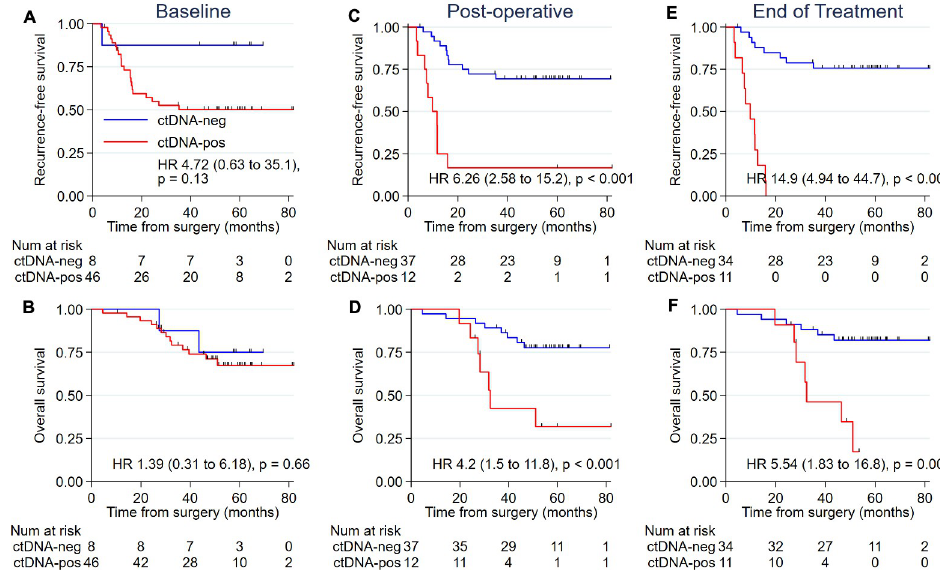
Fig 5. RFS and OS according to ctDNA status at different time points. (A) RFS for baseline ctDNA (T 0 ). (B) OS for baseline ctDNA (T 0 ). (C) RFS for postoperative ctDNA (T P ). (D) OS for postoperative ctDNA (T P ). (E) RFS for end-of- treatment ctDNA (T EOT ). (F) OS for end-of-treatment ctDNA (T EOT ). ctDNA, circulating tumor DNA; OS, overall survival; RFS, recurrence-free survival.